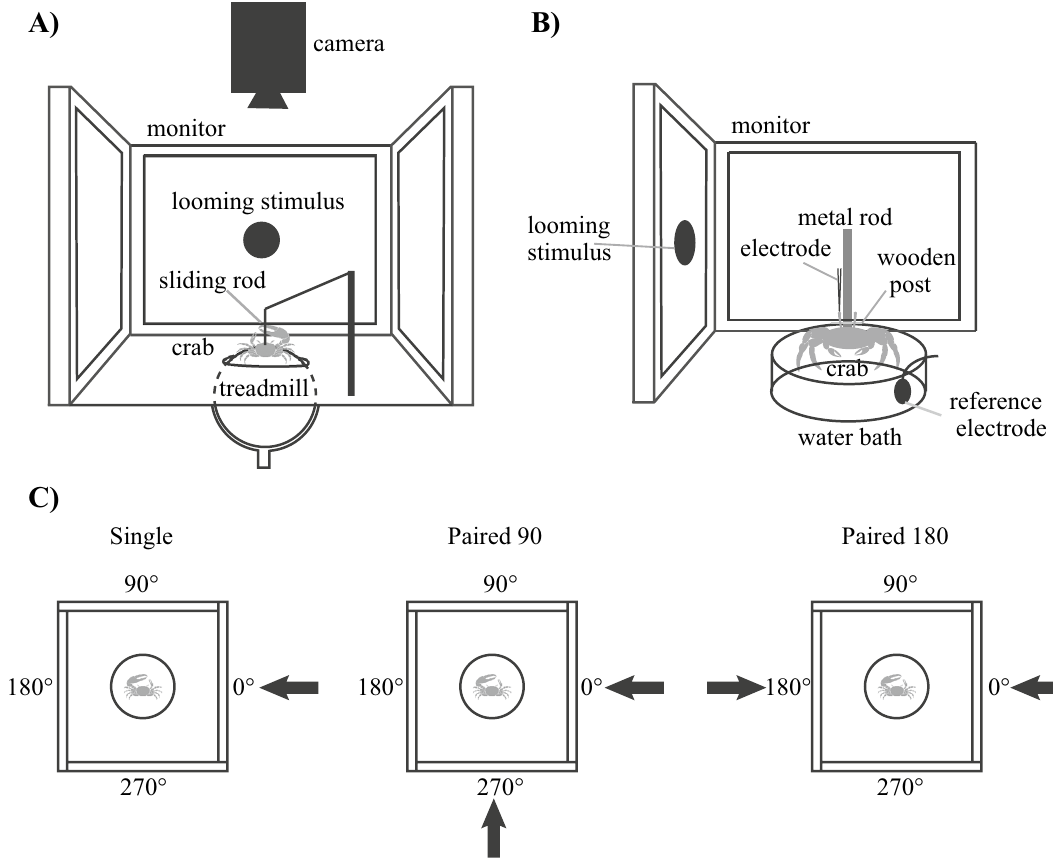
Figure 1. Experimental setups and stimulus configurations. ( A ) The behavioural experiment was conducted on an air cushioned treadmill. Stimuli were presented either on one or two of the four computer monitors surrounding the treadmill. The crab was held in place by a rod attached to its carapace that allowed it to slide up and down and rotate freely around the centre of the ball, but not move away. ( B ) Intracellular in vivo electrophysiology involved inserting an electrode into the optic lobe of crab to record single-neuron responses to stimuli presented on two computer monitors placed at right angles next to each other. The crab was firmly held by gluing it to a metal rod and the eyestalks were stabilized in an approximately natural position, by gluing to a wooden post. A small piece of cuticle was removed from the top of the eyestalk to provide access to the optic lobes. ( C ) The stimuli for the behavioural experiments consisted of (1) a single looming stimulus, presented on any one of the four monitors (Single). (2) A pair of looming stimuli presented on any of two adjacent monitors (Paired 90). (3) A pair of looming stimuli presented on any two opposed monitors (Paired 180). The stimuli used for electrophysiology were the same but excluded the Paired 180 configuration and stimuli were only presented on two